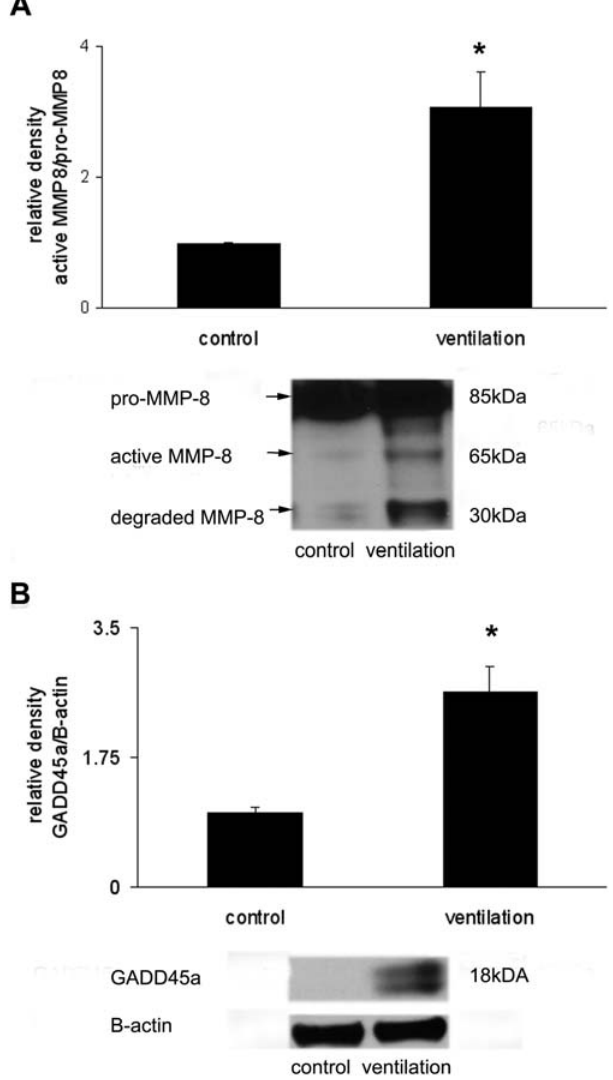
Figure 10. Mechanical ventilation induces MMP8 and GADD45 a expression in mice. (A) Quantified MMP8 activation data, expressed as active/pro-MMP8 following mechanical ventilation (10 ml/ kg, 8 hours). Arrows point at different forms of MMP8. (B) Increased GADD45 a expression was also detected after 8 hours ventilation and expressed as GADD45 a /loading control b -actin. Representative blots are shown. *represents significant differences between ventilation and control